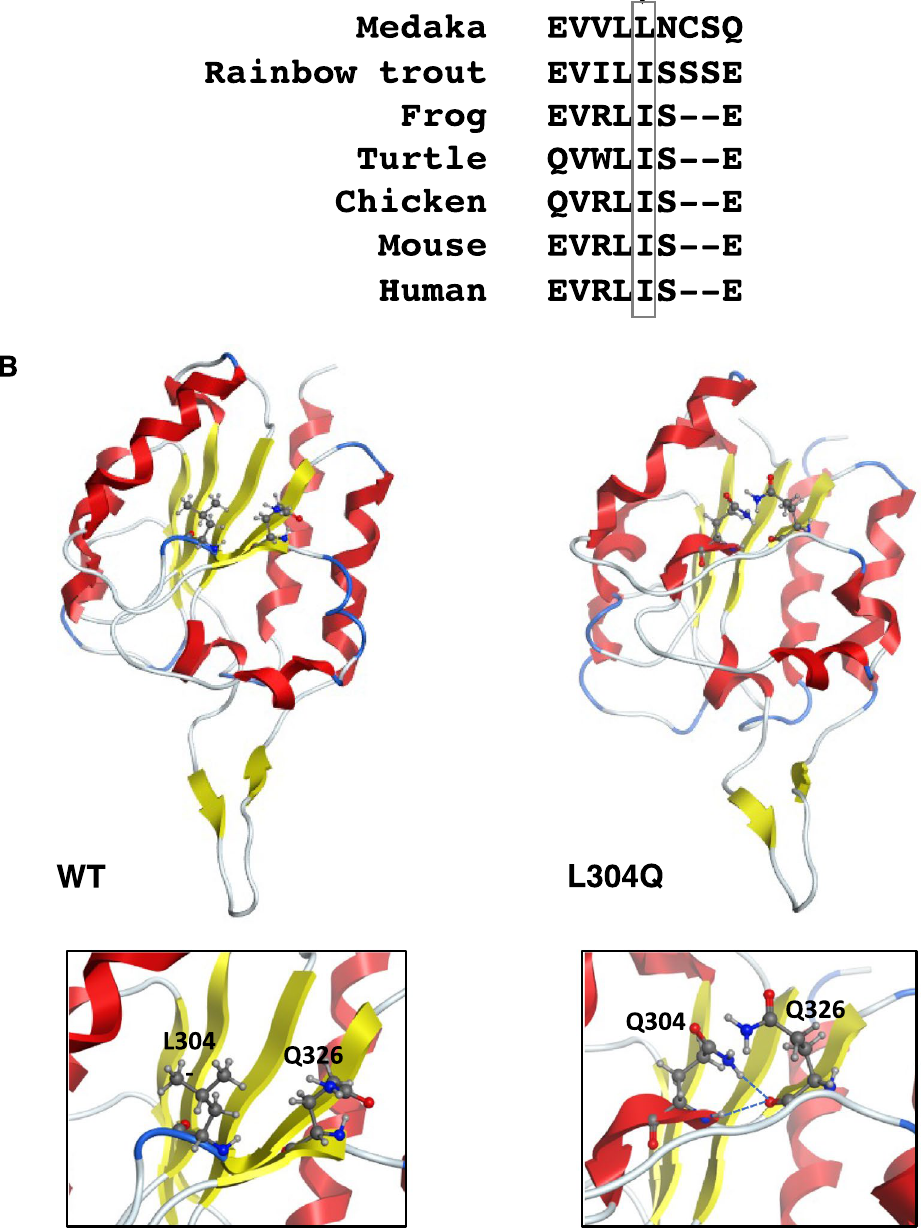
Figure 8. Molecular modeling for WT and L304Q mdkCSS. ( A ) Comparison of the local amino acid sequence around L-304 residue among vertebrates. Medaka, O ryzias latipes ; Rainbow trout, Oncorhinchus mykiss ; Frog, Xenopus tropicalis; Turtle, Mauremys reevesii ; Chicken, Gullus gullus ; Mouse, Mus musculus ; Human, Homo sapiens . ( B ) Molecular modeling of the C-domains of WT and L304Q. These models are constructed by the MOE homology modeling based on the crystal structure of the C-domain of mouse CSS (PDB: 3EWI). Magnified views around L-304 residue are shown at lower panels. Two hydrogen bonds newly appear between H of NH group of the Q304 side chain and O of carbonyl group of the Q326 backbone, and between H of NH group of the Q304 backbone and O of carbonyl group of the Q326 backbone. No such interaction is not observed in